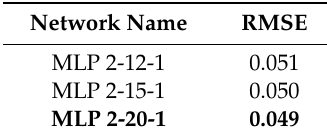
Table 3. Root mean square error (RMSE) values for three MLP neural network (based on acceleration of